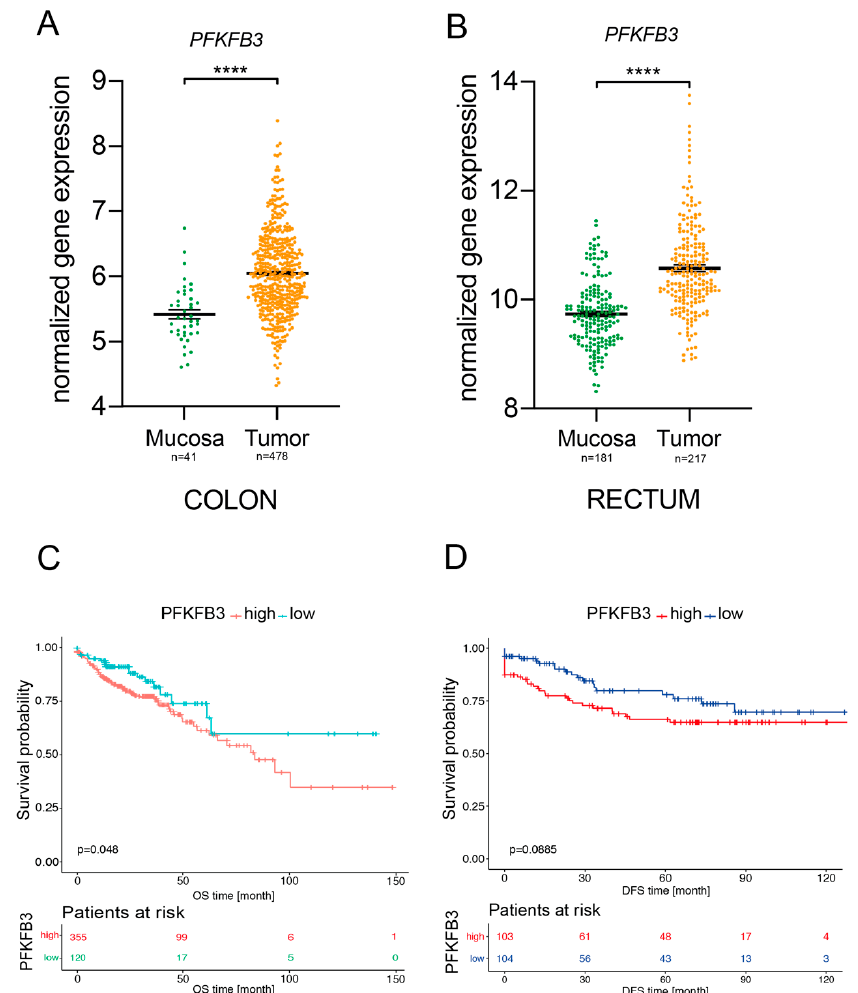
Figure 1. PFKFB3 expression in human colon and rectal cancer. ( A , B ) PFKFB3 mRNA expression on colonic and rectal normal mucosa versus colonic and rectal tumors. ( C , D ) Kaplan–Meier plots for colon cancer overall survival (patients n = 475), and rectal cancer disease-free survival (patients n = 207), respectively, **** p < 0.0001.